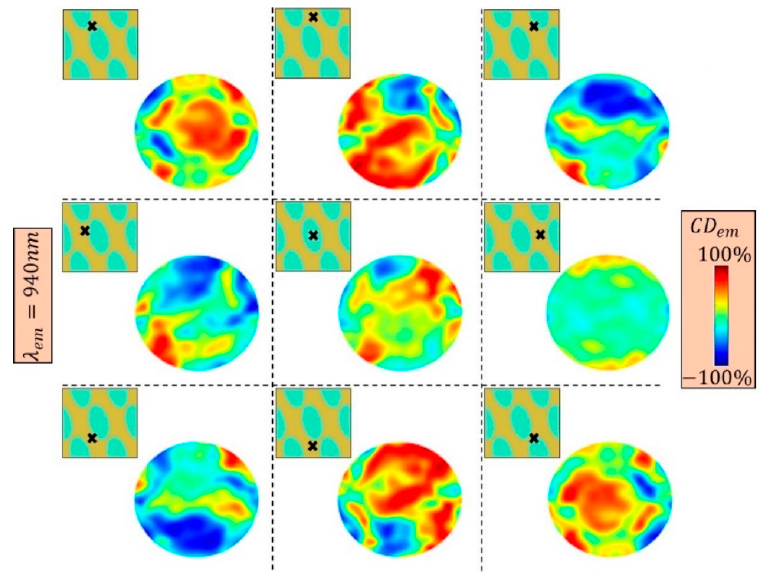
Figure 5. CD em maps for different dipole positions for the Au-ENHA, at 940 nm.